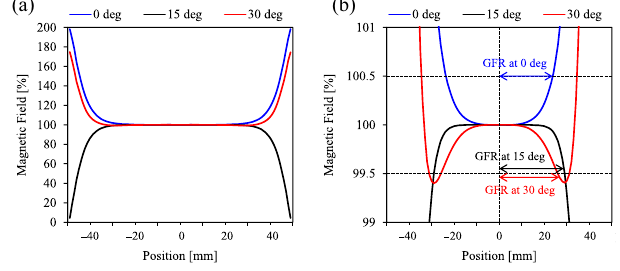
FIG. 5. Magnetic field transverse to scanning plane.